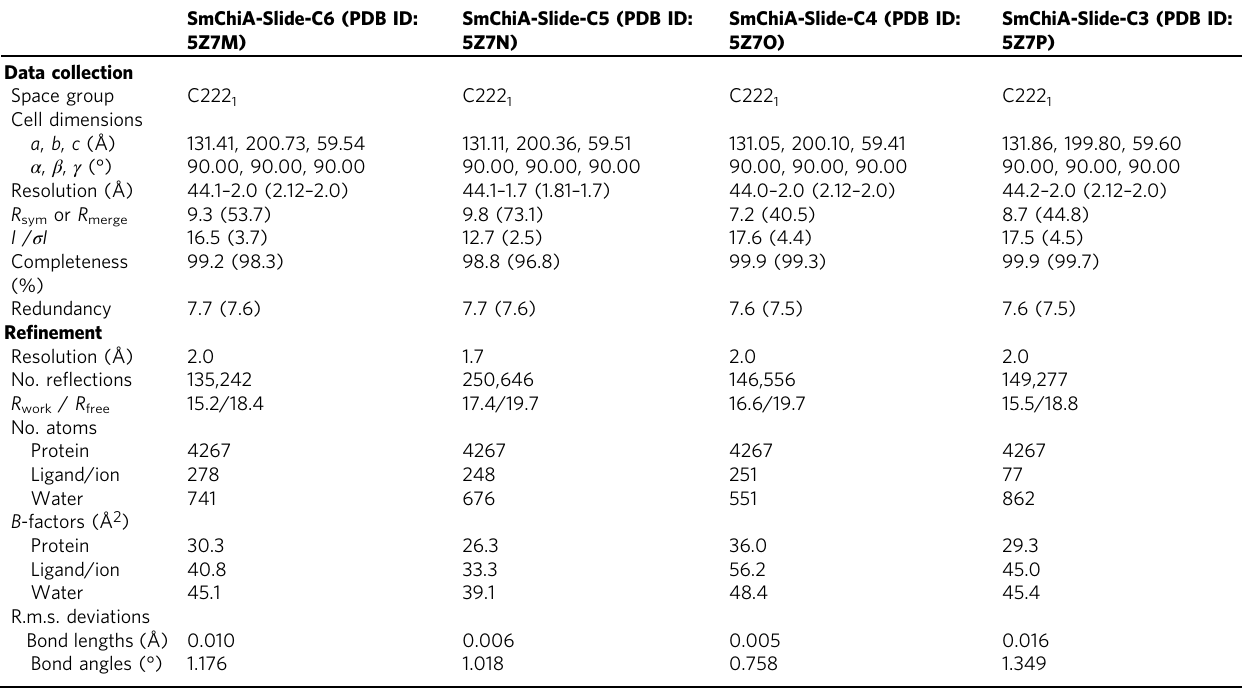
Table 1 Statistics of data collection and re fi nement of the crystal structures of SmChiA with various bound oligosaccharide